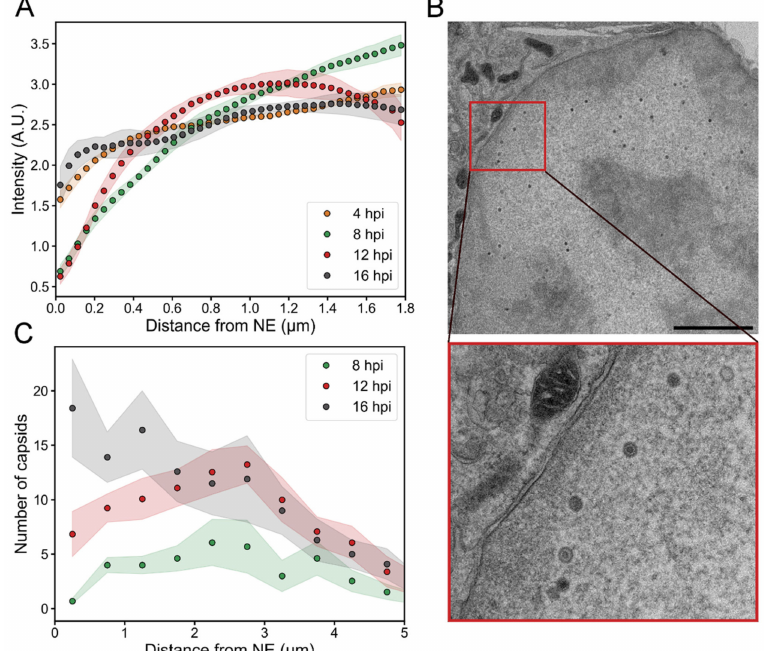
Figure 4. Viral capsid and capsid protein localization in the nucleus. The distribution of the VP5 capsid protein and capsids as a function of the distance from the NE at various times post-infection. ( A ) A quantitative analysis of 3D confocal expansion microscopy images of infected cells ( n = 9–10) showing the localization of VP5 as a function of the distance from the NE. ( B ) A TEM image of an infected cell at 16 hpi. The inset shows an enlarged view of the boxed area containing capsids in the proximity of the NE. Scale bar is 3 µ m. ( C ) An analysis of TEM images illustrating the number of capsids as a function of the distance from the inner nuclear membrane ( n = 10–13). The shaded areas around the lines represent the mean ±